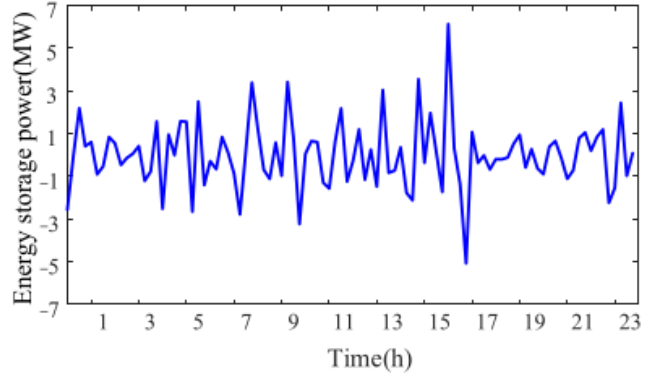
Figure 4. Energy storage power